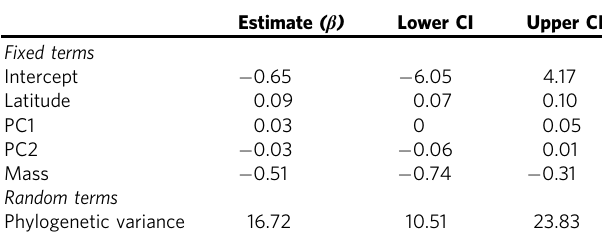
Table 2 Posterior distributions of the parameter estimates of the multinomial Bayesian phylogenetic probit mixed- effects models for fl